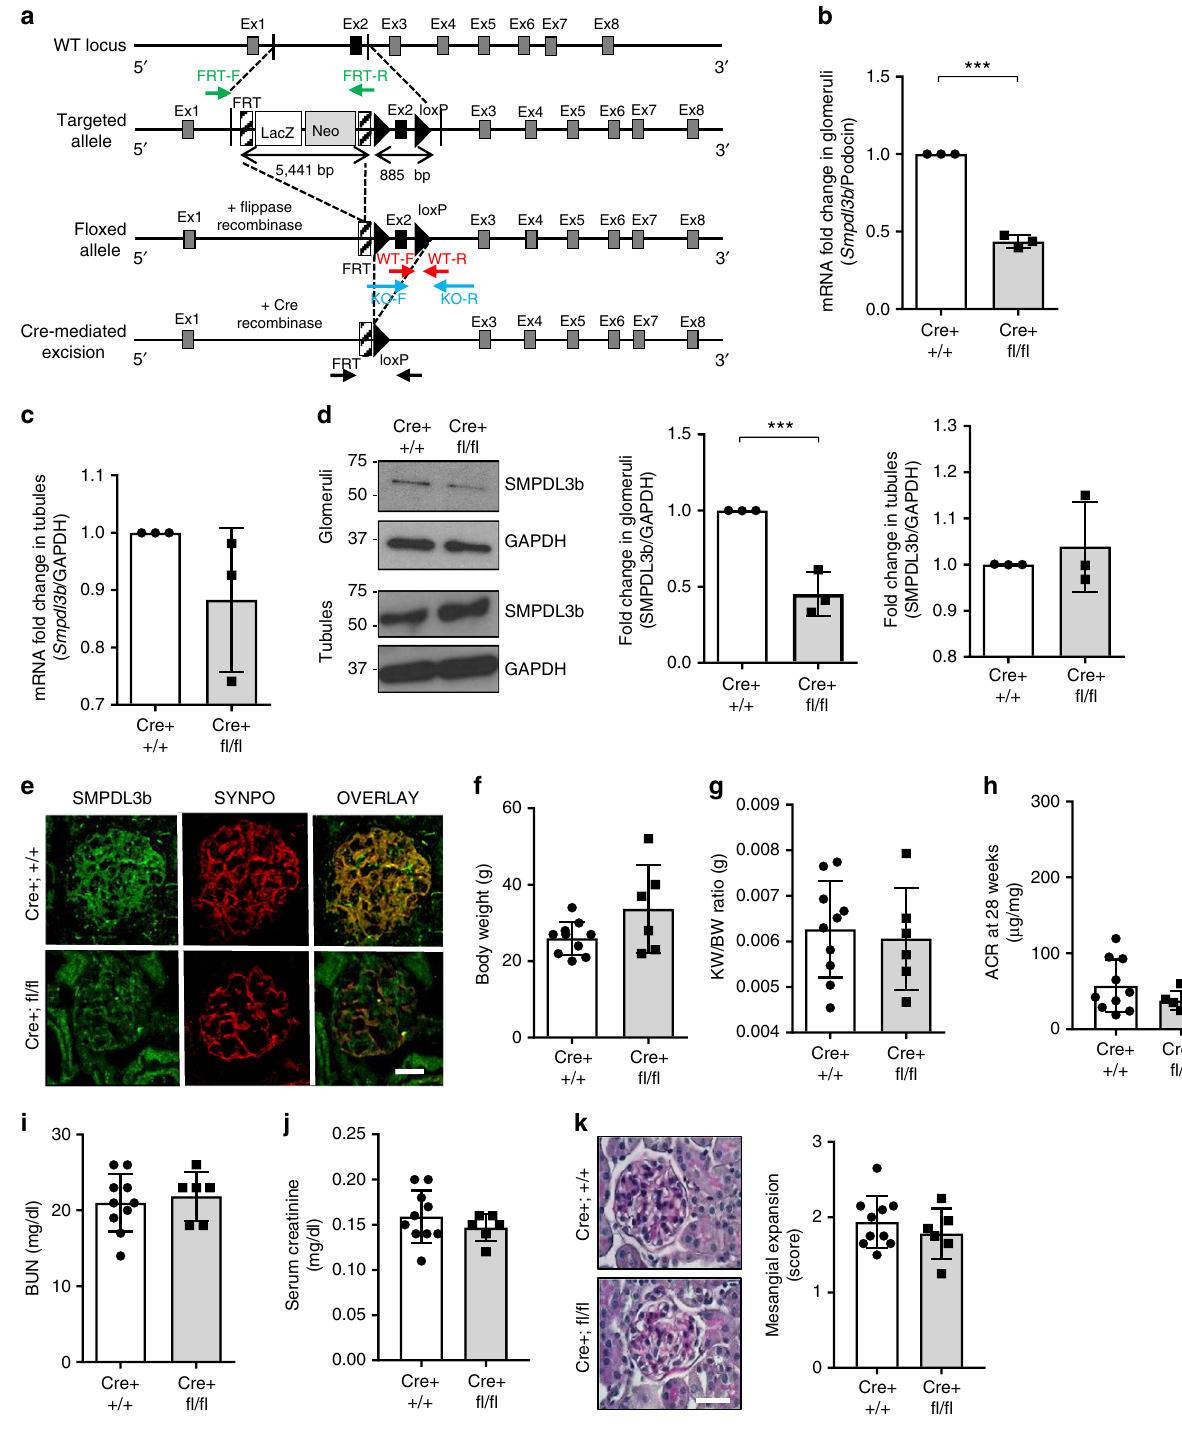
Fig. 4 Podocyte-speci fi c Smpdl3b- de fi cient mice are viable and phenotypically normal. a A schematic representation of the Smpdl3b wildtype allele and targeted locus. Ex1 – 8 exons 1 – 8; primers to detect FRT (green arrowheads), the Smpdl3b fl oxed allele (KO, blue arrows) and Smpdl3b wildtype allele (WT, red arrows) were used. b , c RT PCR of Smpdl3b expression in glomeruli ( b ) and tubules ( c ) pooled from fi ve different mice; *** P = 0.003, two-tailed t -test. n = 3 independent experiments. d Western blot (left panel) and bar graph analysis of SMPDL3b expression in glomeruli (middle panel) and tubules (right panel) pooled from 2 to 5 mice per group; *** P = 0.003, two-tailed t -test. n = 3 independent experiments. e Immunostaining (40×) of SMPDL3b (green) and synaptopodin (red; SYNPO) expression in Cre + ; + / + and Cre + ; fl / fl . Bar scale 30 µ m. f – j Phenotypical analysis of Cre + ; + / + ( n = 10 animals) and Cre + ; fl / fl ( n = 6 animals) 28-week-old mice. Cre + ; + / + or Cre + ; fl / fl mice showed no changes in body weight ( f ), P = 0.076, kidney weight to body weight ratio ( g ), P = 0.715, urine albumin-creatinine ratio (ACR) ( h ), P = 0.208, blood urine nitrogen (BUN) ( i ), P = 0.659 and serum creatinine( j ), P = 0.352; two- tailed t -test. k PAS staining (20×) of 4 μ m kidney sections and bar graph analysis in Cre + ; + / + and Cre + ; fl / fl mice. Bar scale 30 µ m. P = 0.401, two-tailed t -test. Error bars represent standard deviation